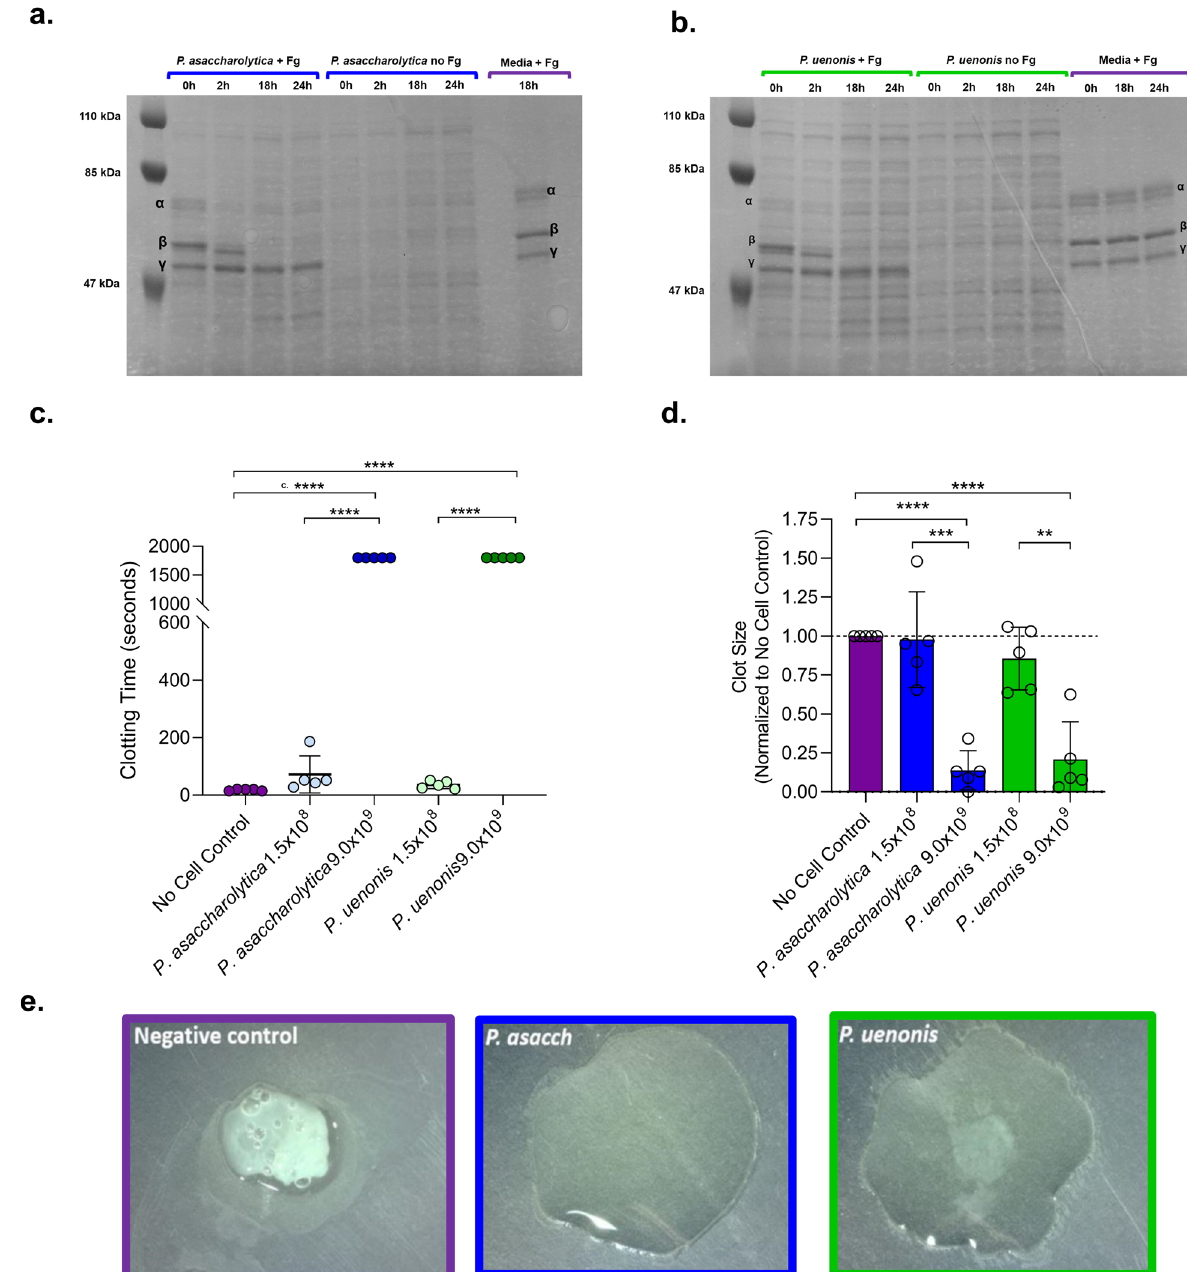
Fig. 2 Vaginal Porphyromonas species degrade fi brinogen and impair clot formation. a , b SDS-PAGE of a P. asaccharolytica and b P. uenonis incubated with human fi brinogen ( + Fg), saline (no Fg), or a cell-free media control (sBHI Media + Fg). Samples were assessed for fi brinogen degradation, indicated by the absence of bands corresponding to α , β , and γ fi brinogen chains in “ Porphyromonas cells + Fg ” treatments compared to “ no Fg ” or media controls. c Time from thrombin addition to fi brin clot formation. Citrated plasma was preincubated with P. asaccharolytica, P. uenonis , or no cell controls. Experiments were performed in technical duplicate and results are presented as mean ± standard error from fi ve independent experiments. d Quantitative evaluation of clot size via well scan optical density measurements at the experimental endpoint. Experiments were performed in technical duplicate and control reactions without thrombin were used to blank the experimental reactions. Data were normalized to the average clot size of the no cell control within each experiment. Results are presented as mean ± standard error from fi ve independent experiments. Signi fi cance was assessed by one-way ANOVA with Holm – Sidak ’ s multiple comparisons test (**** p < 0.0001, *** p < 0.0003, ** p = 0.003). e Endpoint qualitative evaluation of fi brin clots (>30 min) after clotting time assay with P. asaccharolytica (2.4 × 10 9 CFU/reaction), P. uenonis (3.0 × 10 9 CFU/reaction), or no cell treatment did not inhibit activity (Fig. 4b, d). Further to this, the compared to the no inhibitor control (Fig. 4a, c; p = 0.0413). In 1,10-phenanthroline/iodoacetamide combination did not offer keeping with the type I collagen and type IV collagen degradation any additional reduction in protease activity (Fig. 4b, d). results, P. uenonis caseinase activity was signi fi cantly decreased by Inhibitors were also incorporated into the fi brinogen degrada- treatment with the metalloprotease inhibitor 1,10-phenanthroline tion assay to determine whether fi brinogen is proteolyzed by the (Fig. 4c, d; p = 0.018), while aprotinin and iodoacetamide